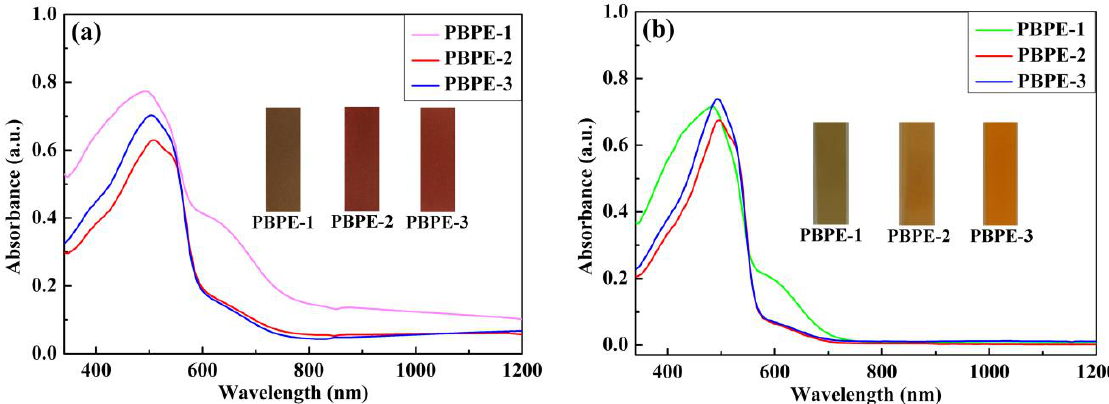
Figure 5. Absorption spectra and color photos of three polymer films ( a ) and solutions ( b ). Table 1. Parameters of the optical and electrochemical properties of three polymers.